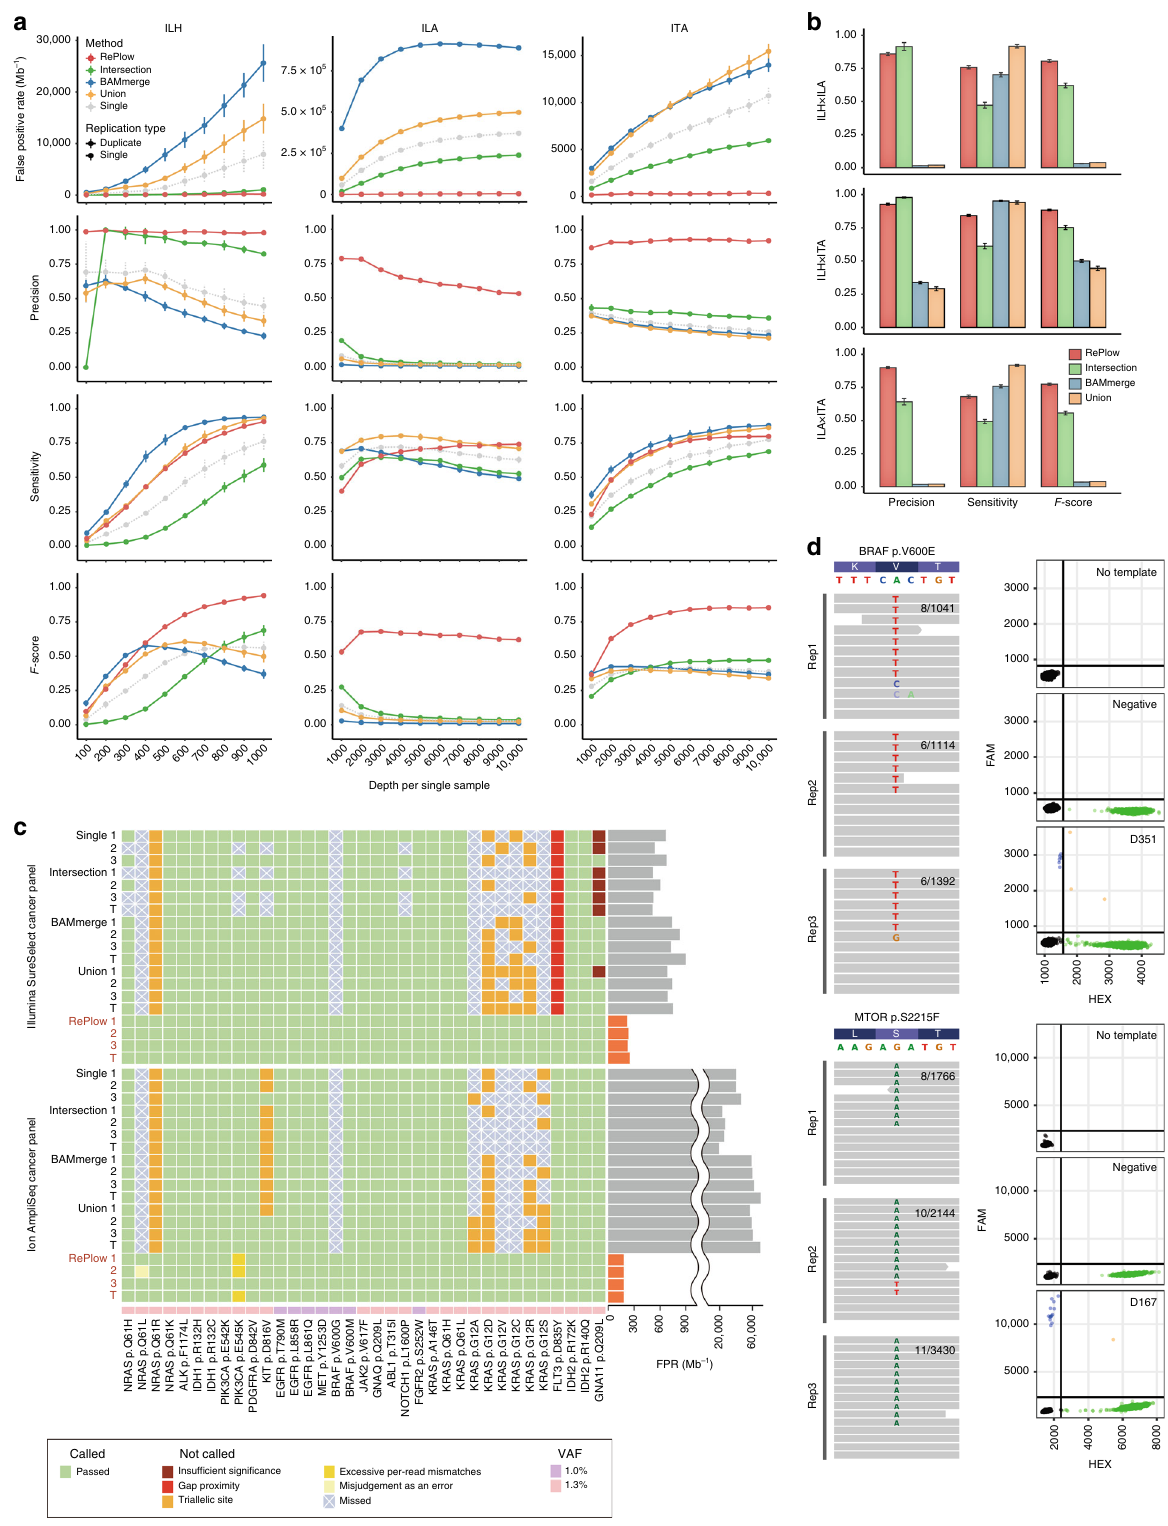
twice from each constructed library; we called these data pairs as sequencing replicates (X 11 and X 12 ). For samples A and B (0.5 and 1% VAF), two library replications (independent preparation of sequencing library from the same DNA sample, X 21 and X 31 ) were additionally performed for all sequencing platforms to compare differences in sequencing and library replication. All generated data were downsampled 10 times (100× to 1000× for ILH and 1000× to 10,000× for ILA and ITA) to track the detecting accuracy by sequencing depth. Details on the sequencing data and preprocessing procedures are described in